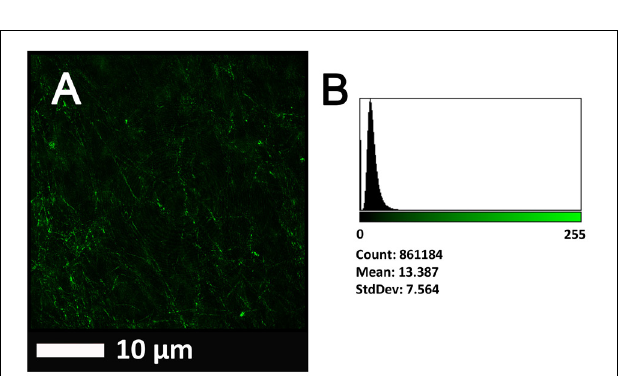
FIGURE 4 | (A) Clot structure from a representative healthy individual as seen with Airyscan super-resolution confocal microscopy. PPP from each individual was incubated with the fluorescent marker ThT. PPP were mixed with thrombin to create an extensive fibrin network. (B) Representative histogram of the 8-bit intensity for the Airyscan clot shown in (A) .